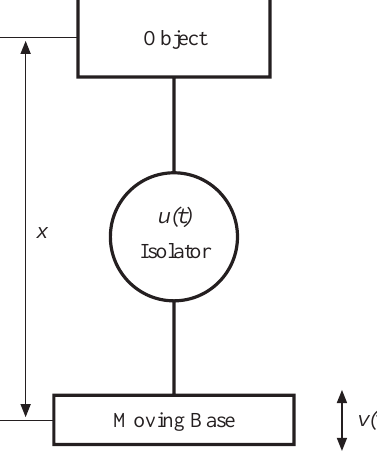
Fig. 1. The object to be isolated on a base subject to the